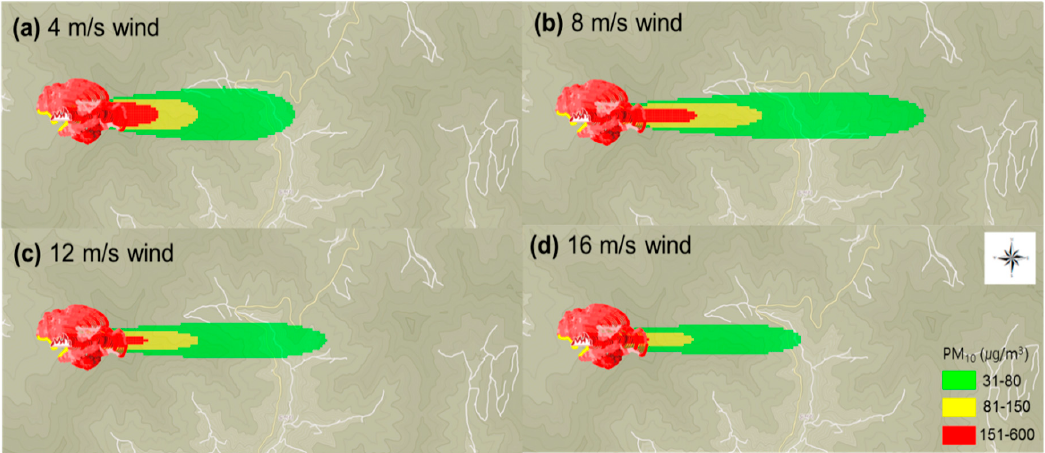
Figure 7. Comparison of the effects of wind speeds on predicted dispersions of PM 10 plume concentration contours: ( a ) 4 m/s winds, ( b ) 8 m/s winds, ( c ) 12 m/s winds, and ( d ) 16 m/s winds. Both fires and predicted PM 10 surface concentrations are shown. PM 10 is coarse (<10 µm) particulate matter.